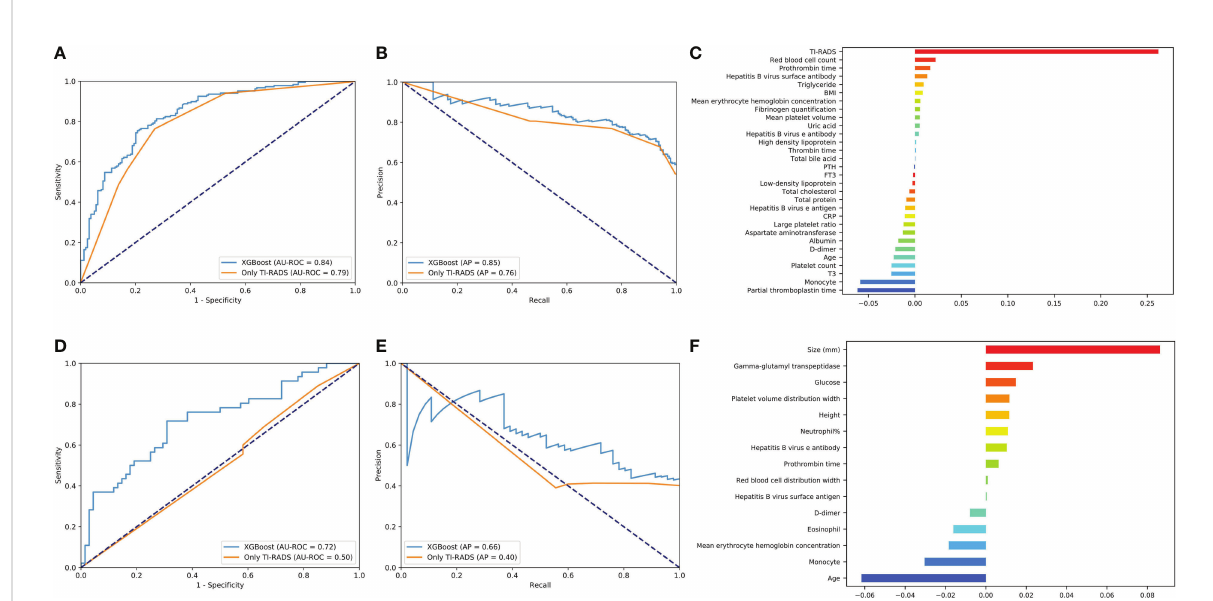
FIGURE 2 Evaluation of the malignant and lymph node metastasis predictive models. (A, D) The average ROC curves from of XGBoost and Only TI-RADS models in the validation sets. (B, E) The average PR curves, indicating the tradeoff between precision and recall. (C, F) The histogram describes the important features of the XGBoost predictive model for malignant and lymph node